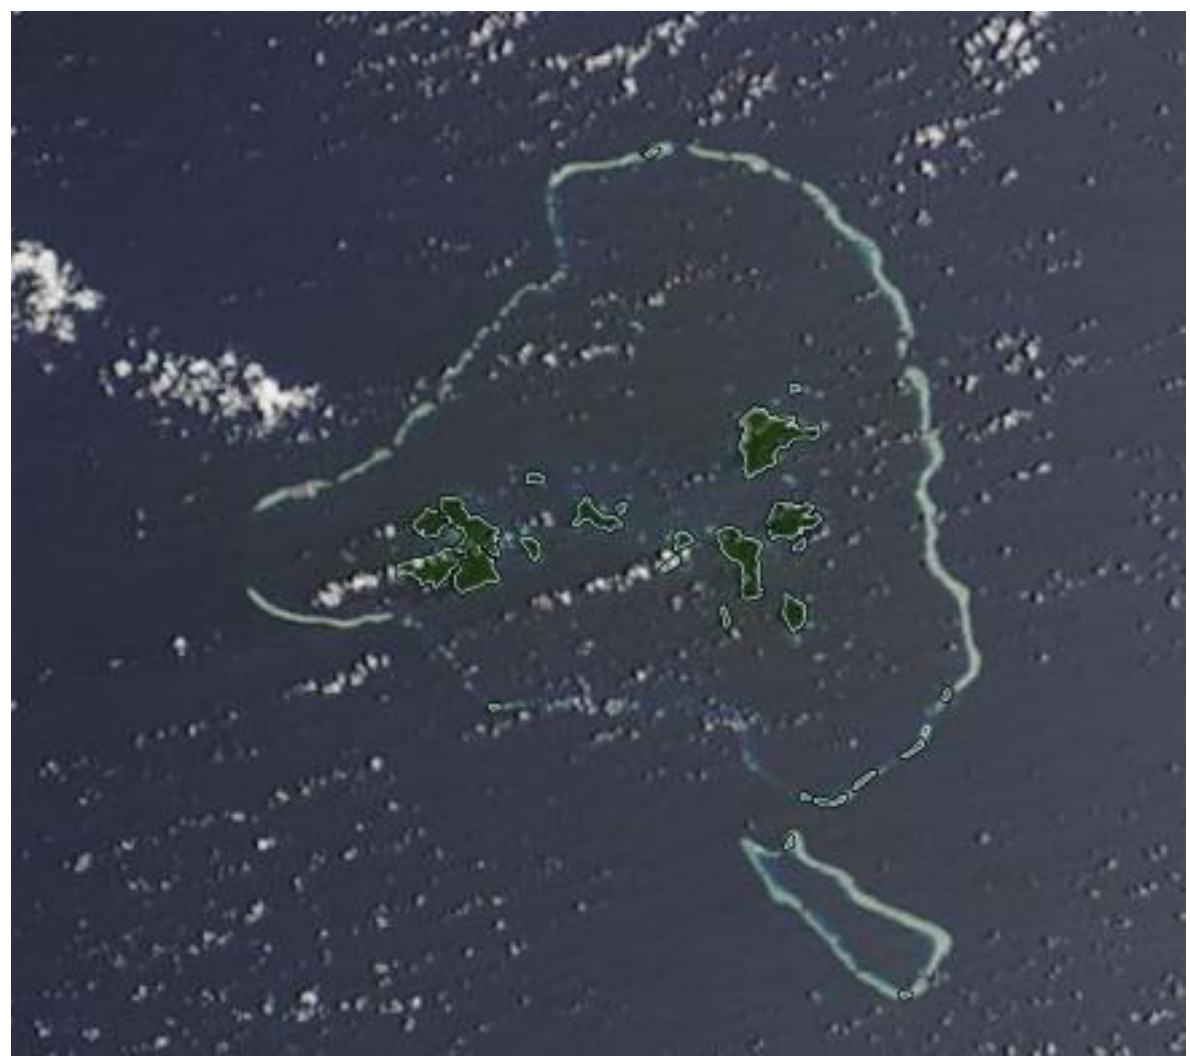
Figure 13. MODIS-Terra snapshot image of Chuuk Lagoon, acquired on 29 March 2013. (North is at the top.) The snapshot was downloaded from the NASA Worldview web service [8] at 250 m resolution. The southern and eastern sides of the lagoon are open to the adjacent ocean waters, while the island and reef boundary is thicker and more contiguous on the northern and western sides.